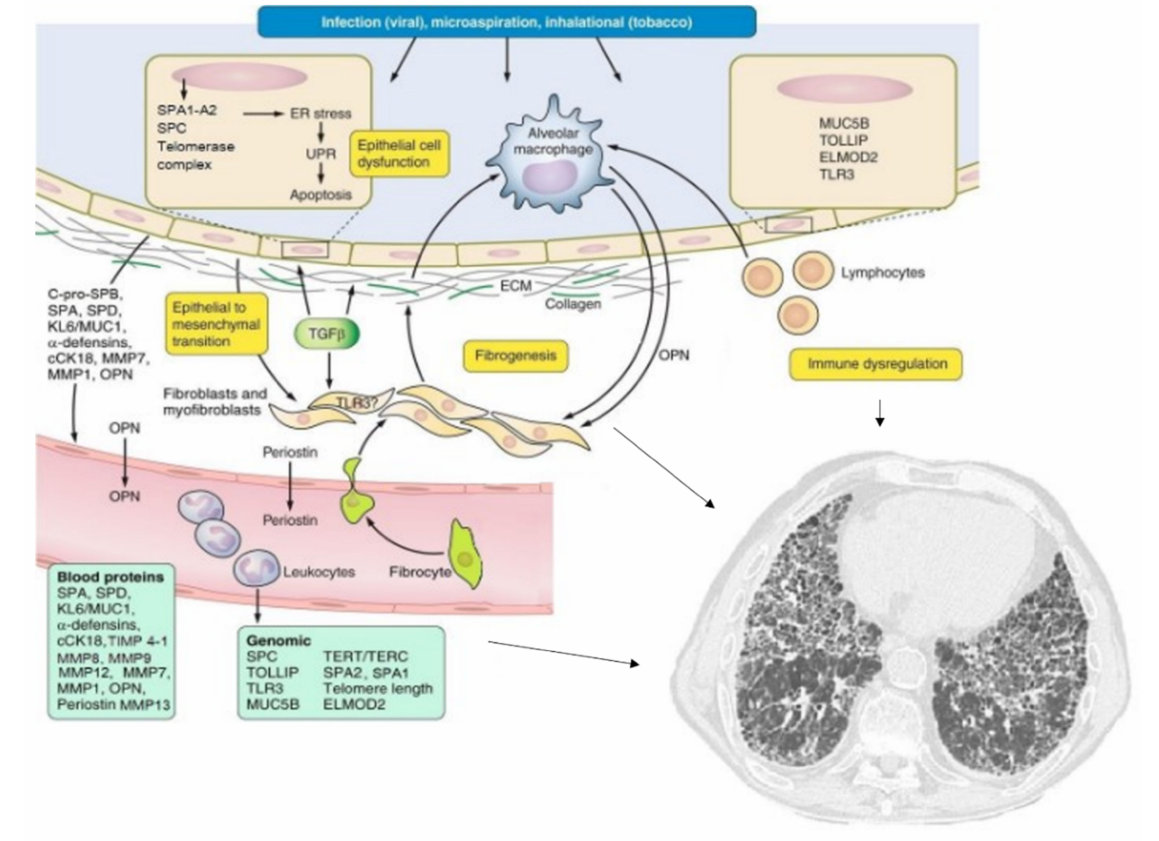
Figure 1. Pathogenesis and molecular biomarkers of idiopathic pulmonary fibrosis. Various mechanisms (most of them indicated by the arrows) leads to pulmonary fibrosis (see text for details). Adapted from Ley B, et al. Am. J. Physiol. Lung Cell Mol. Physiol . 2014 , 307 , L681–L691